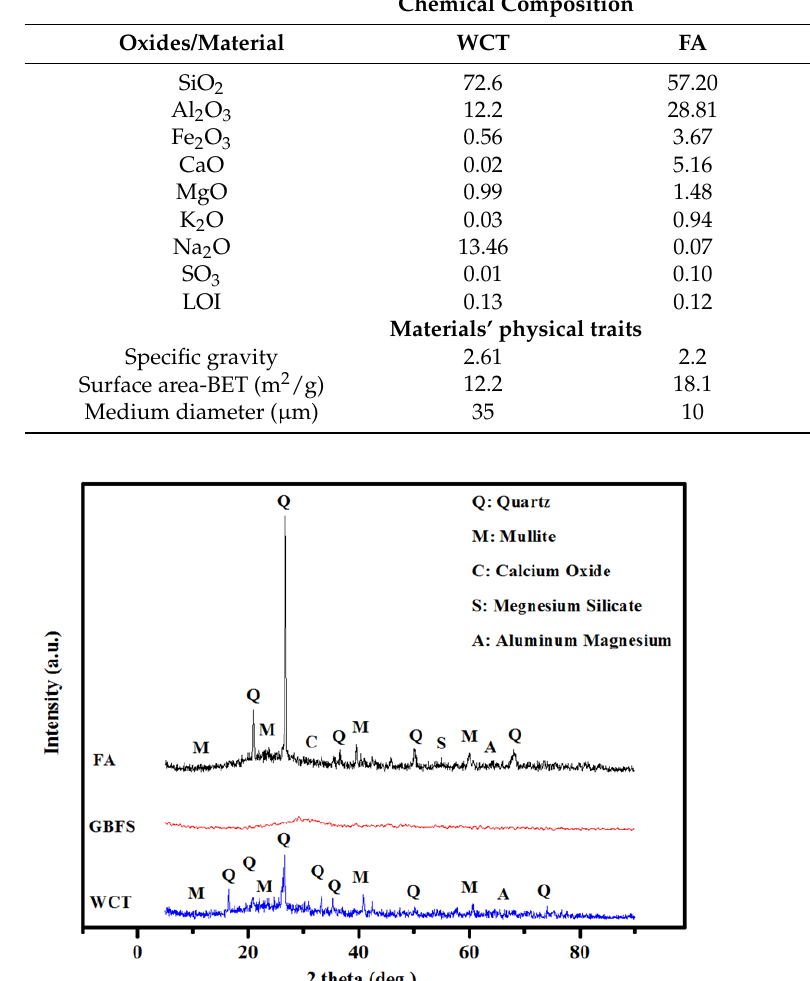
Figure 15. POFA lab treatment.